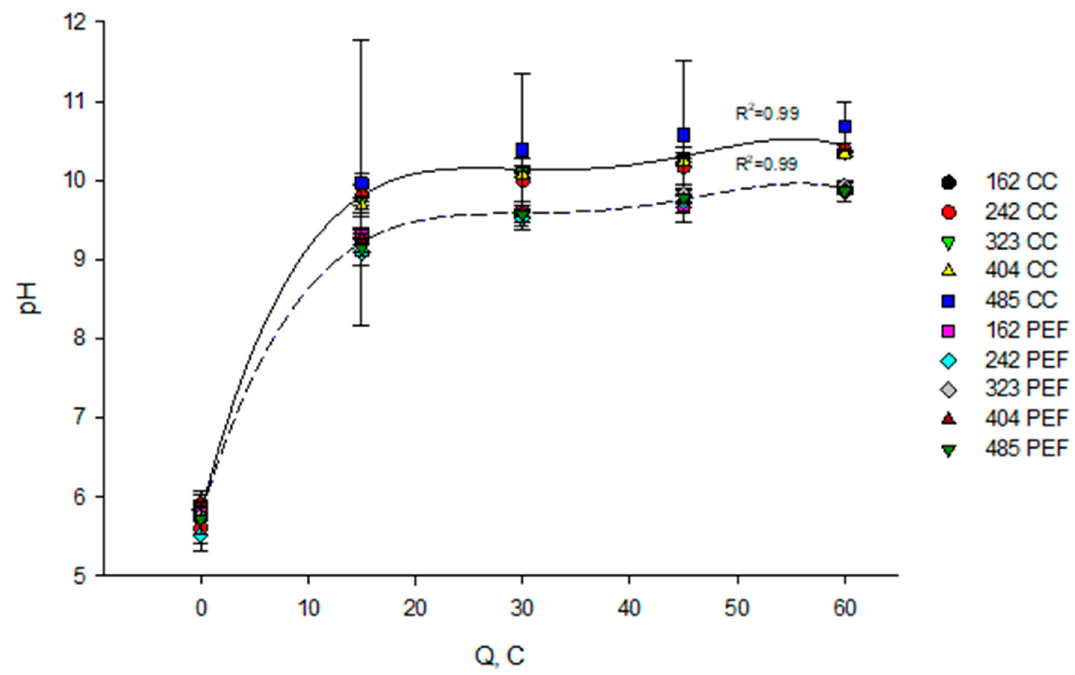
Figure 3. Evolution of KCl solution pH as a function of the number of charges transported (in Coulomb) during EDBM carried out in di ff erent flow rates (corresponding to indicated Reynolds numbers) and current modes (PEF in dashed line and CC in solid line). Reynolds numbers of 162, 242, 323, 404 and 485 correspond to flow rates of 400, 600, 800, 1000 and 1200 mL / min respectively. CC—constant current and PEF—pulsed electric